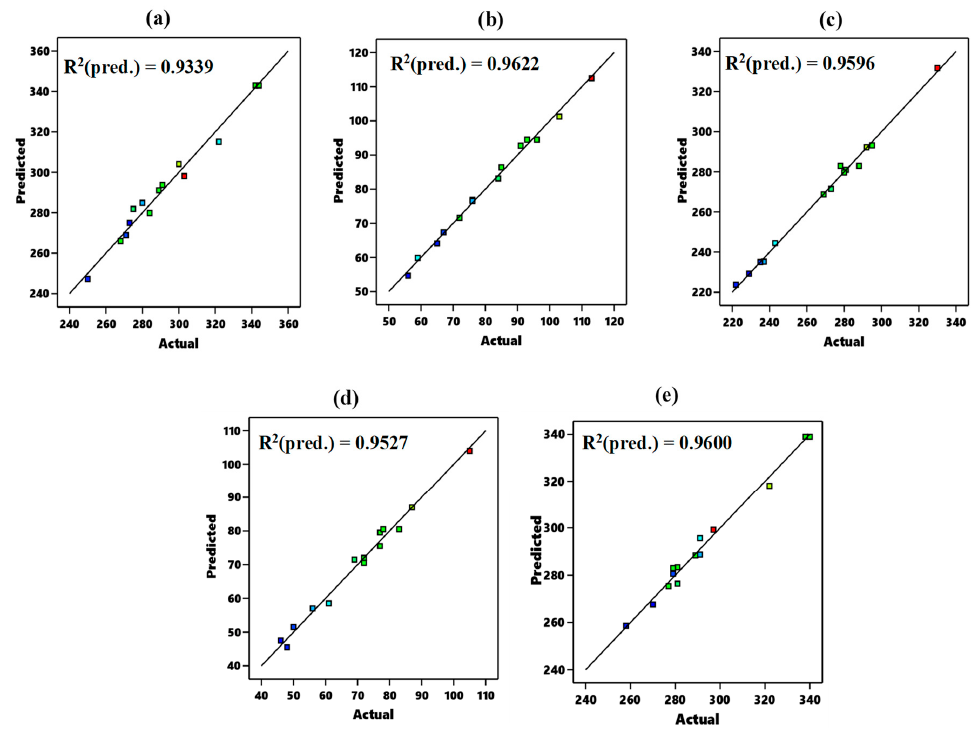
Figure 8. Predicted vs. actual plot for responses ( a ) tensile strength, ( b ) tensile modulus, ( c ) compressive strength, ( d ) compressive modulus, and ( e ) flexural strength.